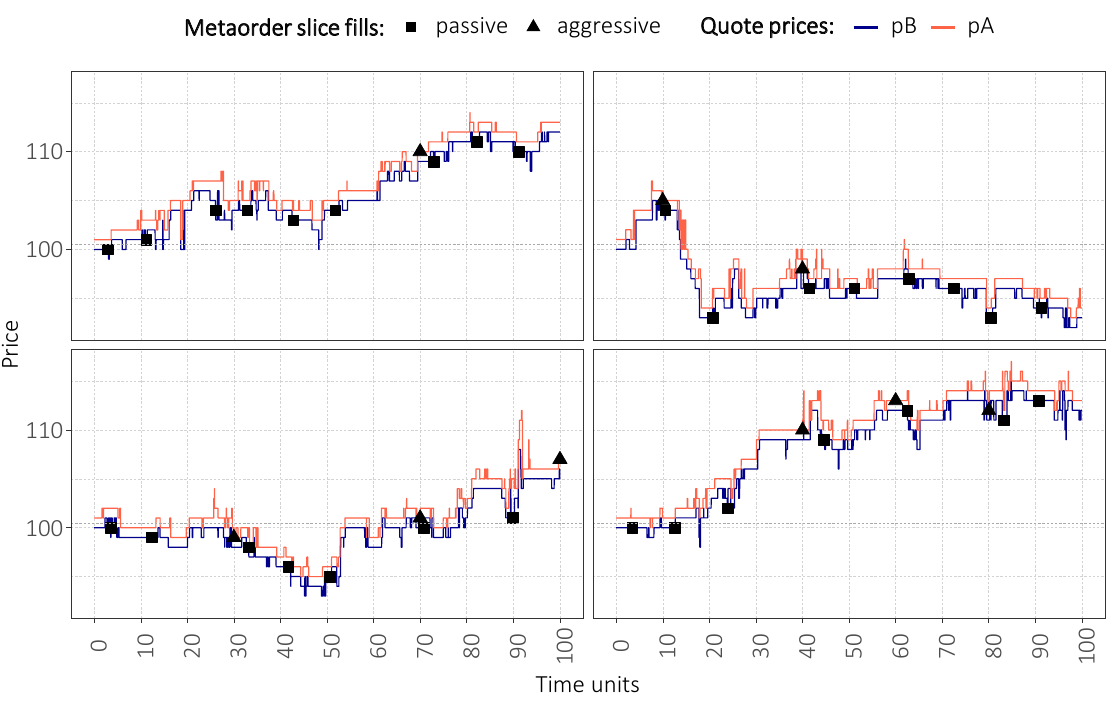
Figure 3. Examples of simulated price dynamics with metaorder traded every 10 time